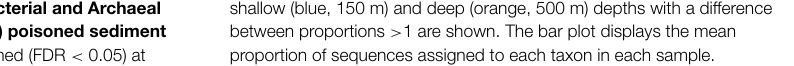
FIGURE 5 | Pairwise comparisons of selected Bacterial and Archaeal taxa in 150m vs. 500m (A) live sediment traps, (B) poisoned sediment traps, and (C) seawater. Only taxa significantly enriched (FDR < 0.05) at